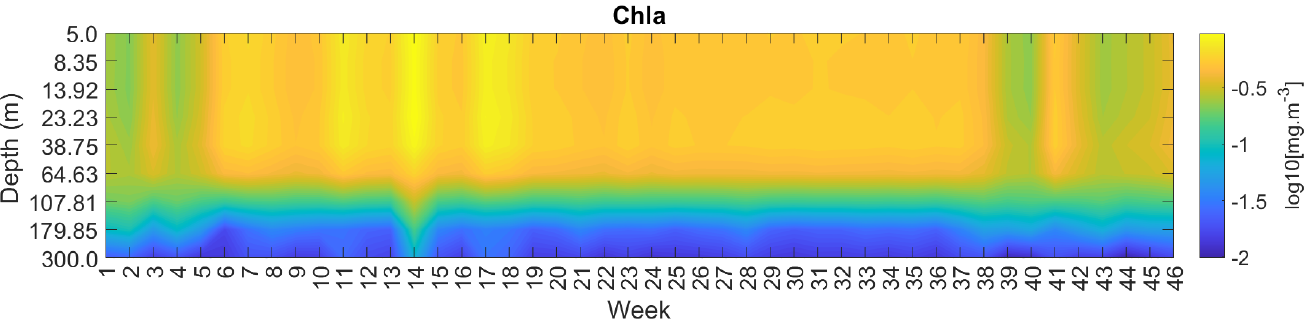
Figure 5. Chla inverted profiles over time.